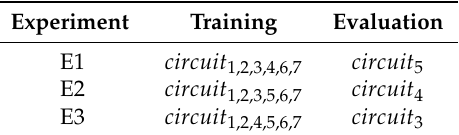
Table 4. Summary of experiments and